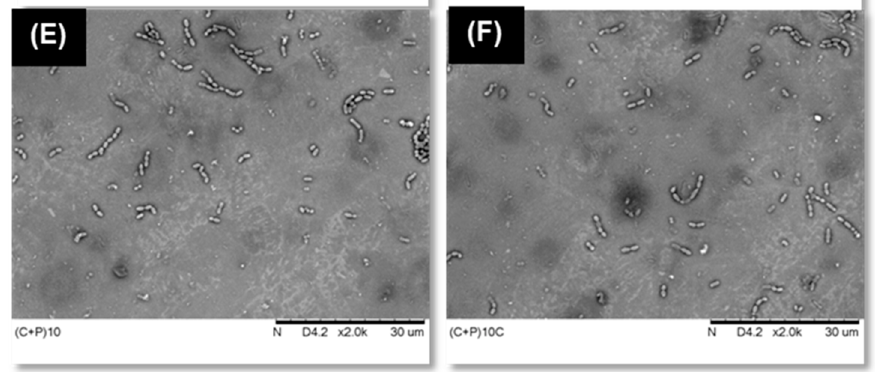
Figure 5. Antibacterial acivity of LbL surfaces against S. gordonii . ( A ) ATP and CFU of S. gordonii bacteria cultured on non-coated pTi and different LbL-coated surfaces ( B – D ) SEM pictures of S. gordonii bacteria on ( B ) pTi; ( C ) pTi with one layer of chitosan (Ti + C); ( D ) One bi-layered ((C + P) 1 ); ( E ) 10 bi-layered ((C + P) 10 ); and ( E ) 10 bi-layered surface with one additional chitosan coat as the outermost layer ((C + P) 10 C).